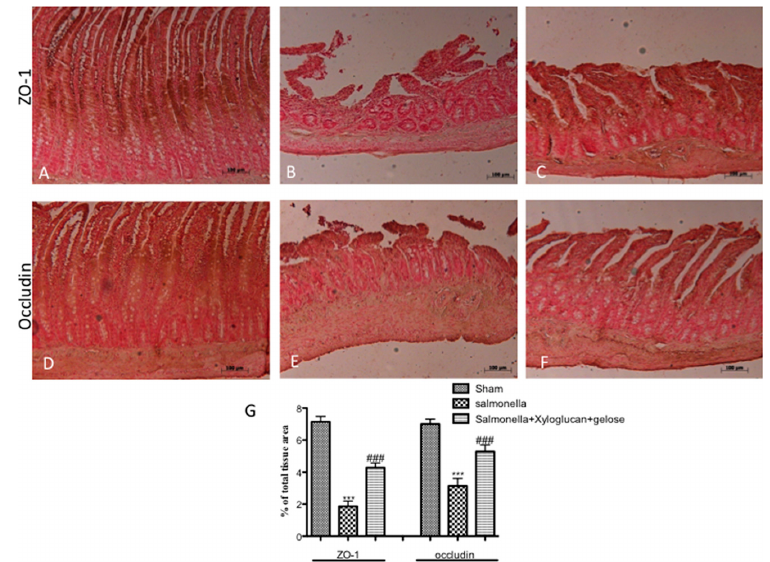
Figure 4. Immunostaining for ZO-1 and occludin expression in sham mice (( A ) and ( D ) respectively); positive staining for ZO-1 and occludin following S. enterica infection (( B ) and ( E ) respectively) and mice treated with xyloglucan + gelose (( C ) and ( F ) respectively). ( G ) Densitometric analysis. Data are representative of at least three separate experiments. Images are representative of all animals in each group. Pictures were captured at 10× magnification (scale bar = 100 μ m). Figures are representative of at least three separate experiments. Values are means ± SEM of 10 animals for each group. (ZO-1). *** p < 0.01 vs. Sham, ### p < 0.001 vs. S. enterica ; (occludin) *** p < 0.001 vs. Sham and ### p < 0.001 vs. S. enterica.